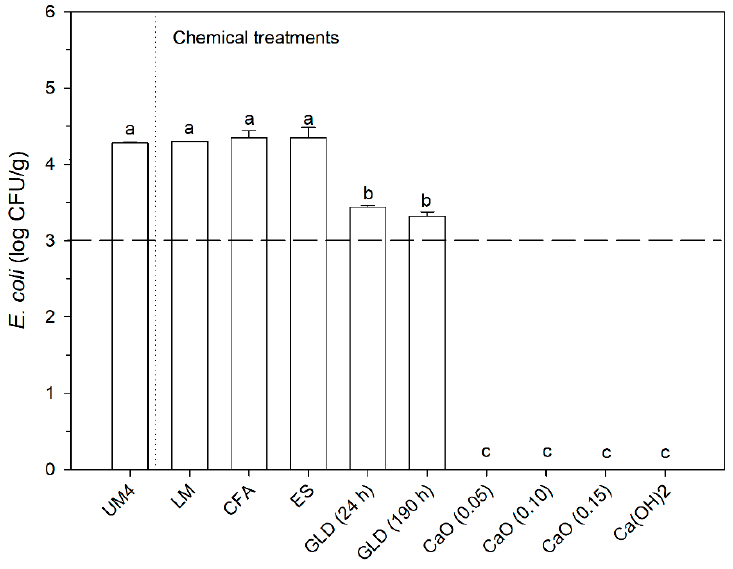
Figure 6. E. coli enumeration after chemical treatment of sample UM4 (Results marked with the same letters are statistically similar (Tukey HSD test with p < 0.05)).